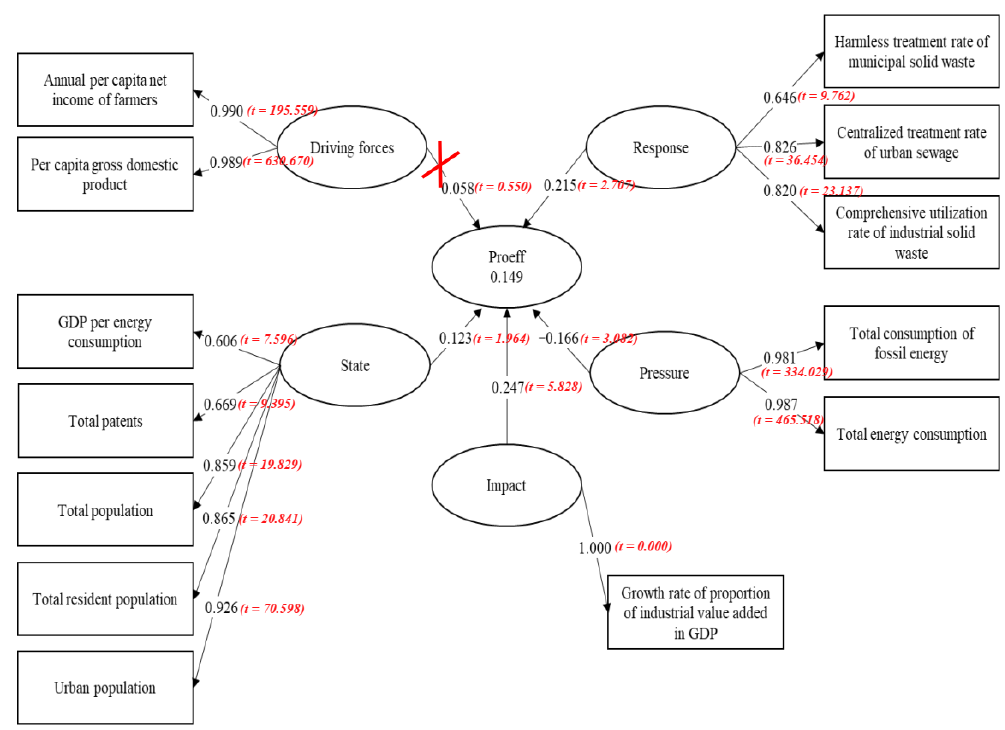
Figure 9. Influencing factors of efficiency in production stage based on DPSIR and PLS-SEM. (Source: Authors compiled).